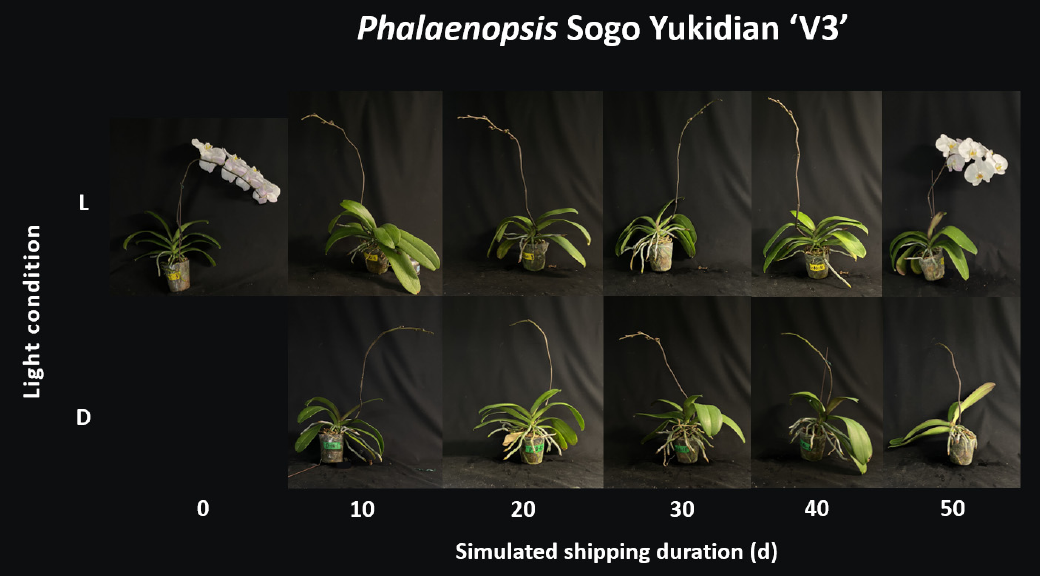
Figure 9. Effect of simulated shipping duration with or without lighting on post-shipping performance of Phalaenopsis Sogo Yukidian ‘V3’. Photos were taken 170 days after the start of simulated shipping. L = light, D = dark.